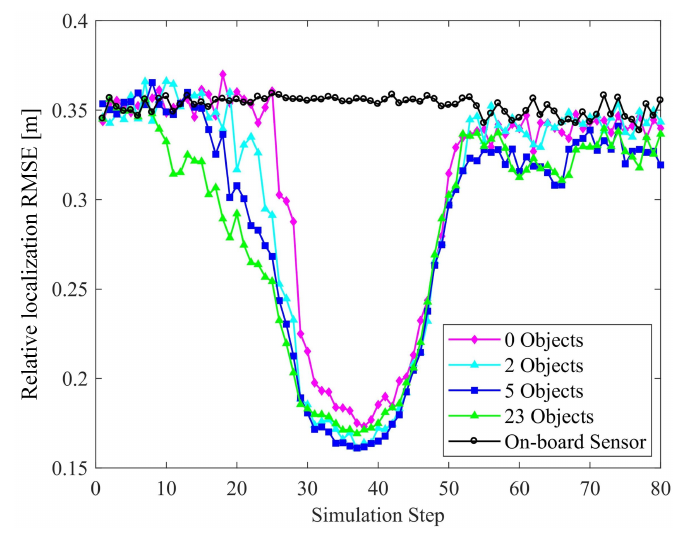
Figure 15. Effect of the number object on perception